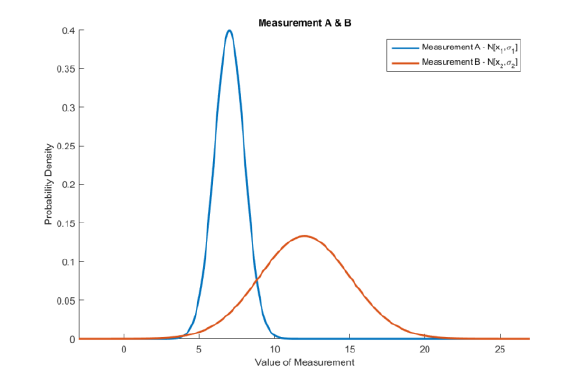
Figure 7. To illustrate the mathematical aspect of the